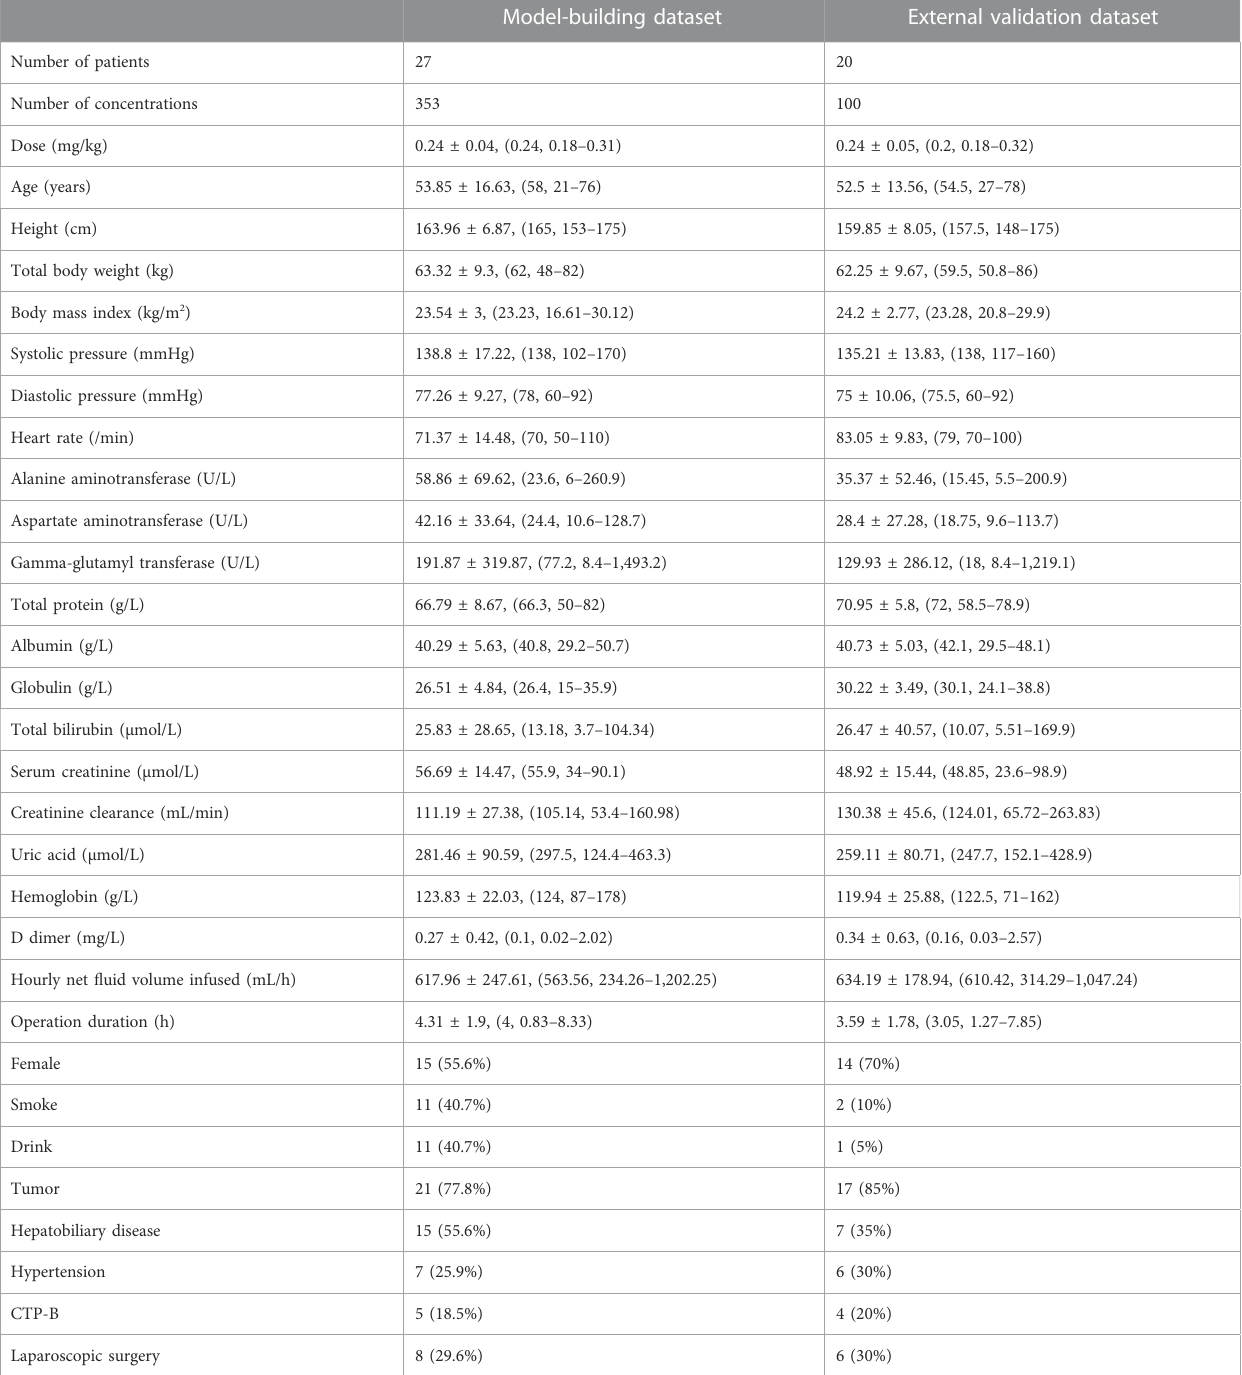
TABLE 1 Baseline demographics characteristics and clinical laboratory measurements of patients included in the